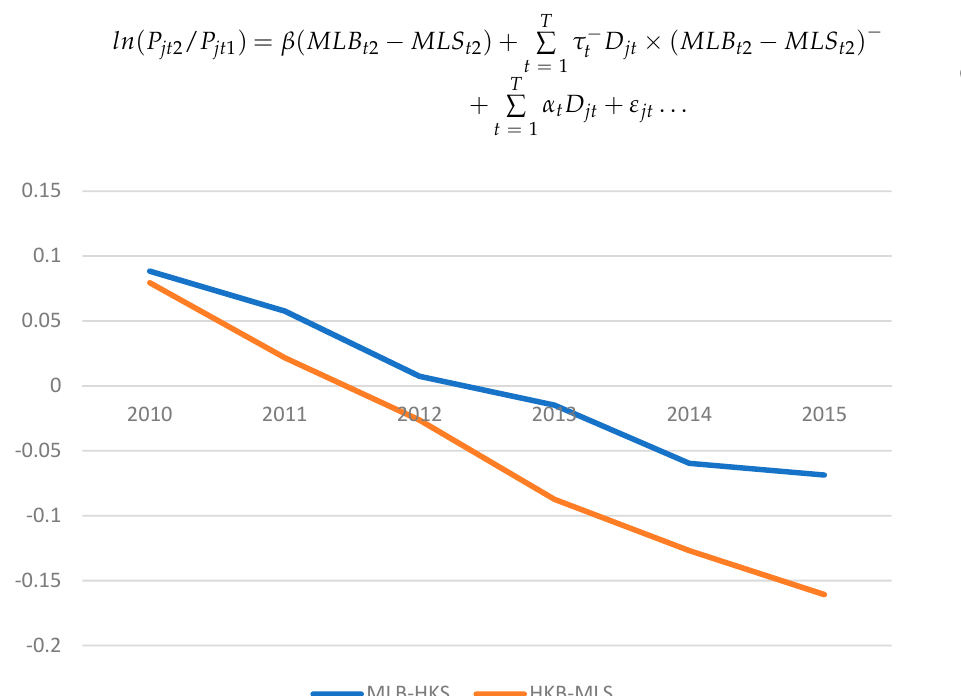
Figure 5. Temporal Changes of Price Differentials for Non-local Buyers and Sellers in Repeat-sale Model. Notes: MLB-HKS represents the coefficients of the interactive terms denoted by 𝜏 (cid:3047)(cid:2878) + 𝛽 in Equation (8) that non-local buyers engage with the local seller (i.e., MLS = 0), HKB-MLS represents the coefficients of the interactive terms denoted by −𝜏 (cid:3047)(cid:2879) − 𝛽 in Equation (9) that local buyers engage with the non-local seller (i.e., MLB = 0). The time dummies are yearly dummies.